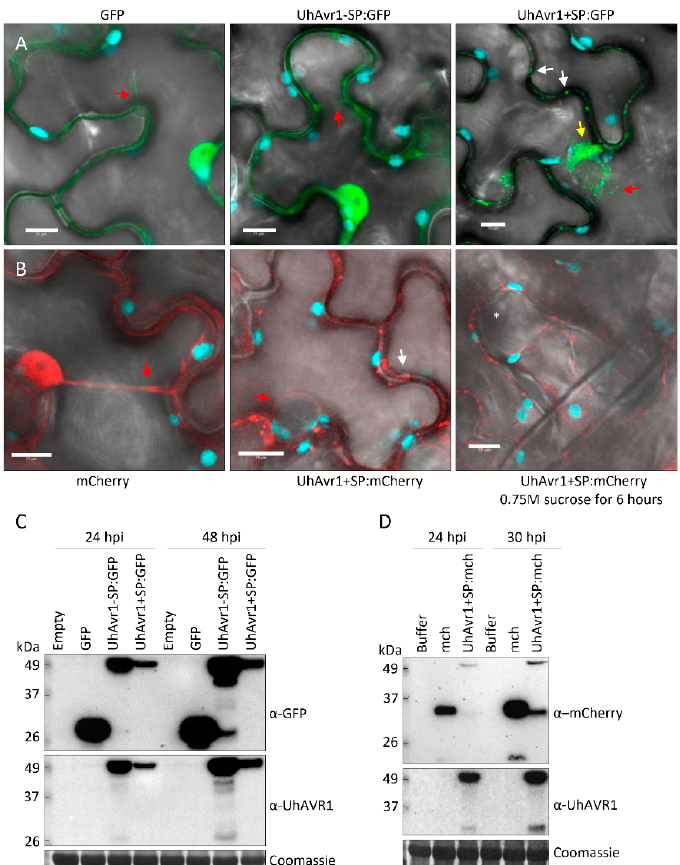
Figure 8. UhAVR1 localizes to the cytosol of N. benthamiana cells. Confocal imaging of N. benthamiana leaves 24 h after agroinfiltration with constructs expressing fluorescent UhAVR1 chimers. ( A ) Free GFP (control) and UhAvr1-SP:GFP fluorescence localized to the nucleoplasm and cytosol (red arrow) whereas UhAvr1+SP:GFP fluorescence localized to the cytosol (red arrow) and cytosolic foci (white arrows). Protein aggregation in the cytosol could be occasionally seen at 24 hpi (yellow arrow). ( B ) Fluorescence from free mCherry was seen in the nucleoplasm and cytosol (red arrow) whereas, when infiltrating construct UhAvr1+SP:mCherry, fluorescence was seen in the cytosol (red arrow) and cytosolic foci (white arrow) at 24 hpi. Cells expressing UhAvr1+SP:mCherry were subjected to plasmolysis with 0.75M sucrose for 6 h; no mCherry could be detected in the apoplastic space (asterisk). ( C ) Protein blots of the same batch of plants used for panel A showed the expression of intact GFP (27 kDa), UhAvr1-SP:GFP (47 kDa) and UhAvr1+SP:GFP (49 kDa) at 24 and 48 hpi. ( D ) Protein blots from the same batch of plants used for panel B showed mCherry (27 kDa) and SP-cleaved UhAVR1:mCherry (46 kDa) at 24 hpi and 30 hpi (plasmolysis). These are predicted protein molecular sizes and may slightly vary from the apparent sizes when run on gels; some smaller breakdown products are seen. Three independent repeats of confocal microscopy and protein blots were performed, and representative results are shown. Images of panel A and B were produced by merging GFP or mCherry, chlorophyll and bright field channels. A snapshot of a single optical section is displayed for all confocal images and scale bars represents 10 µm.